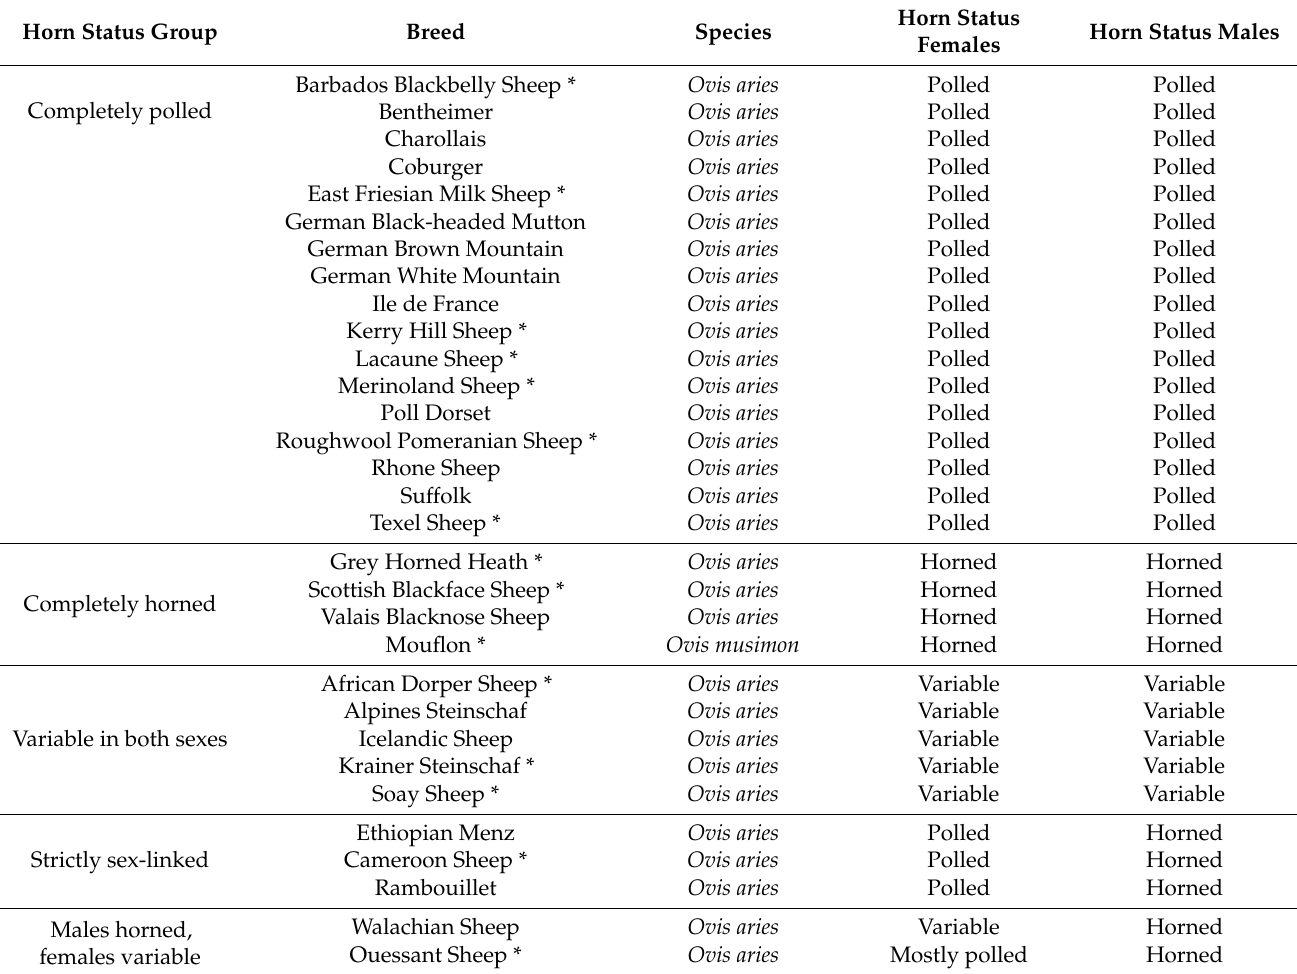
Table 2. List of sheep breeds ( Ovis aries ), including the European mouflon ( Ovis musimon ), showing different horn phenotypes between sexes. Individuals of the respective sex and breed are either horned, polled, or the horn status is variable (there are polled, horned, and scurred